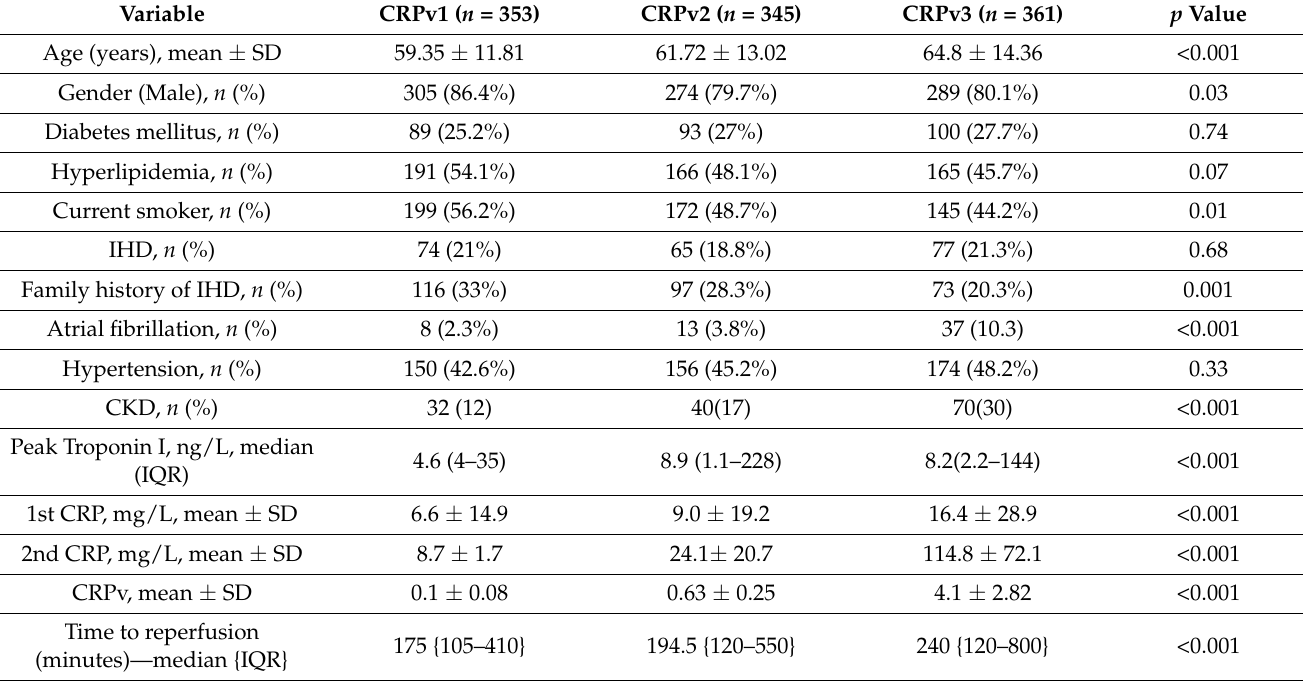
Table 1. Baseline patient